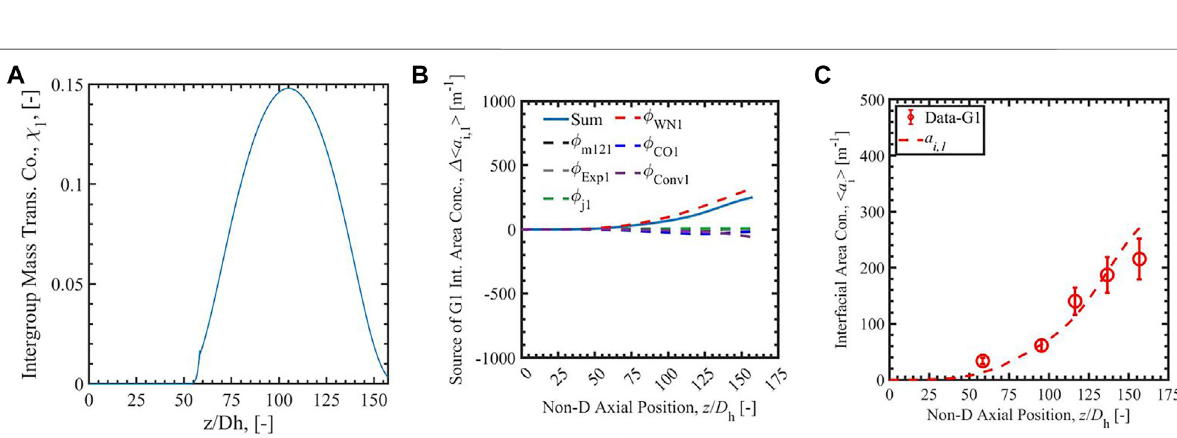
Frontiers in Energy Research |